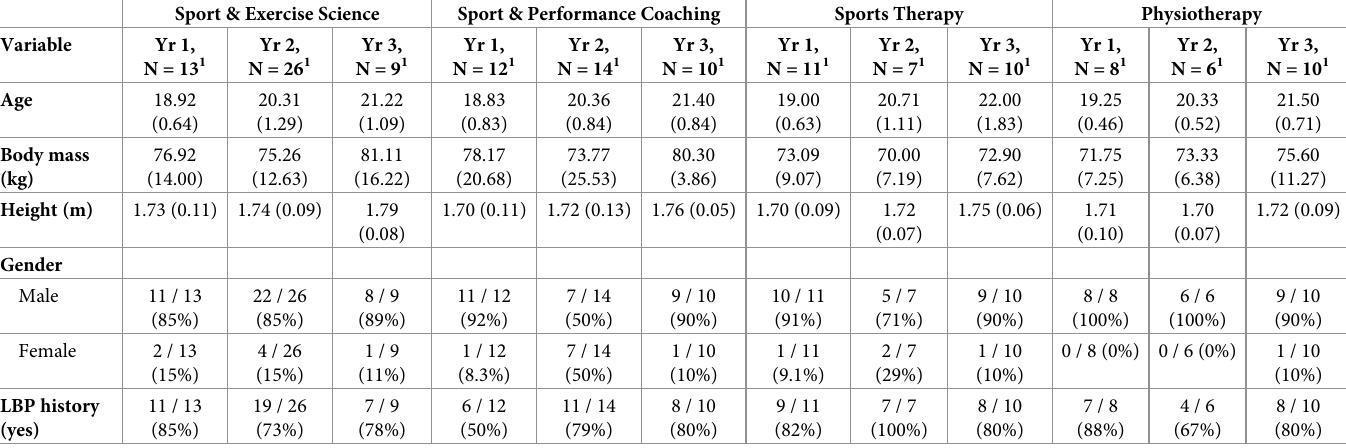
Table 1. Descriptive characteristics of included participants. Sport & Exercise